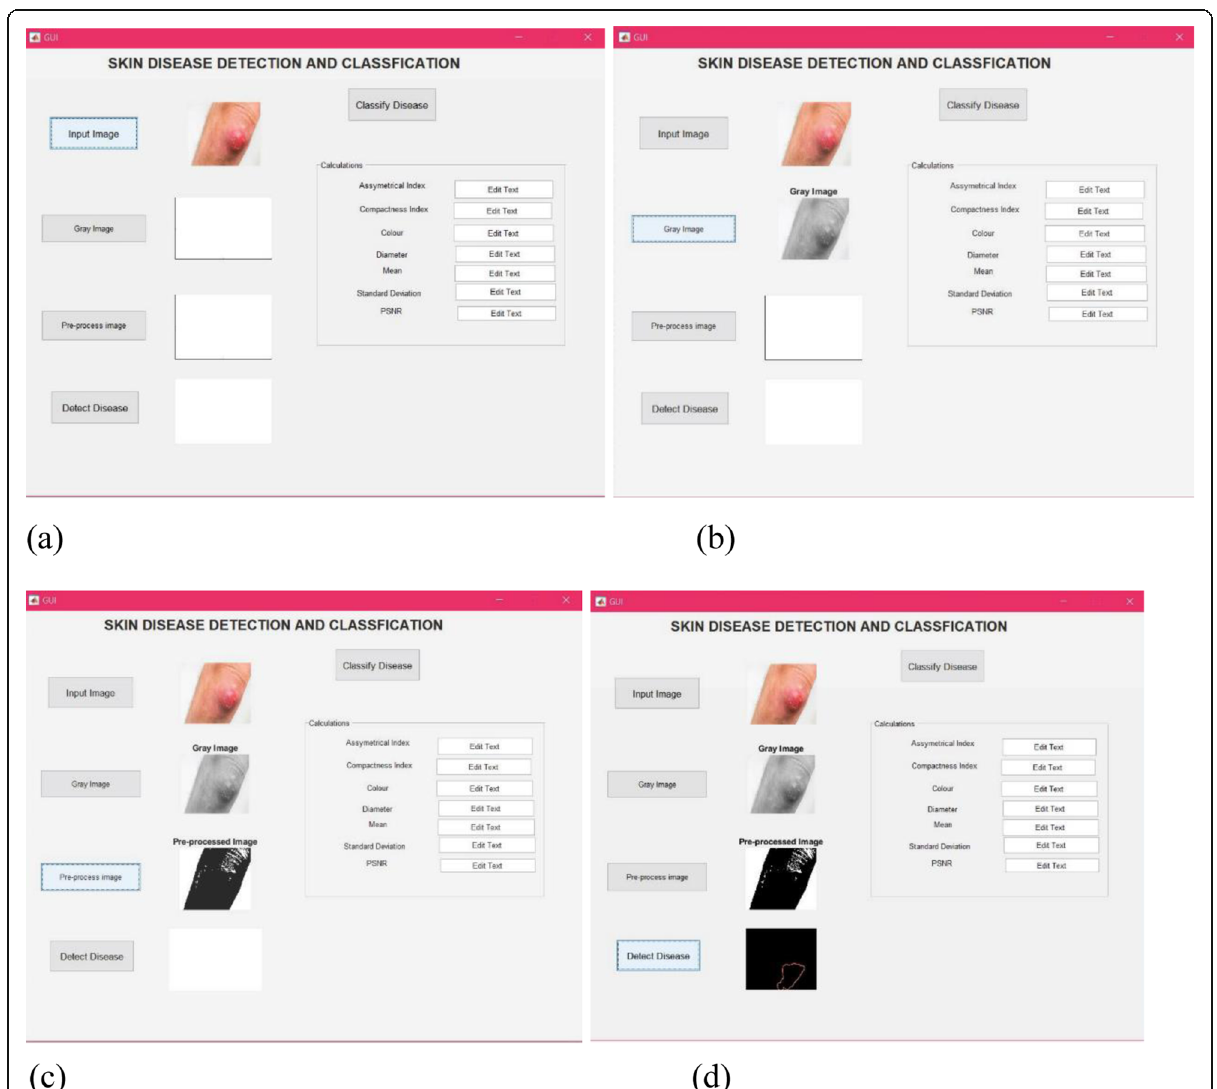
Fig. 4 The results of each step on the GUI screen. a : Result for input image; ( b ): Result for gray image button; ( c ): Result for pre-processing image button; ( d ): Results of the detection of disease